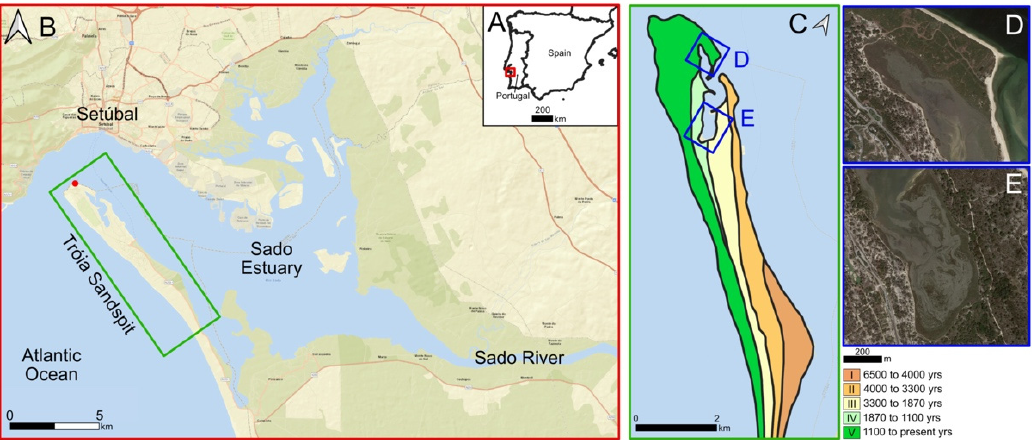
Figure 1. Test area locations. ( A ) Location in the Iberian Peninsula; ( B ) Sado estuary and Tróia sandspit. The red dot indicates the location of Setúbal-Tróia tide gauge; ( C ) Tróia sandspit evolution phases [41]; ( D ) C. Tróia (N) (Google satellite); ( E ) C. Tróia (S) (Google satellite).